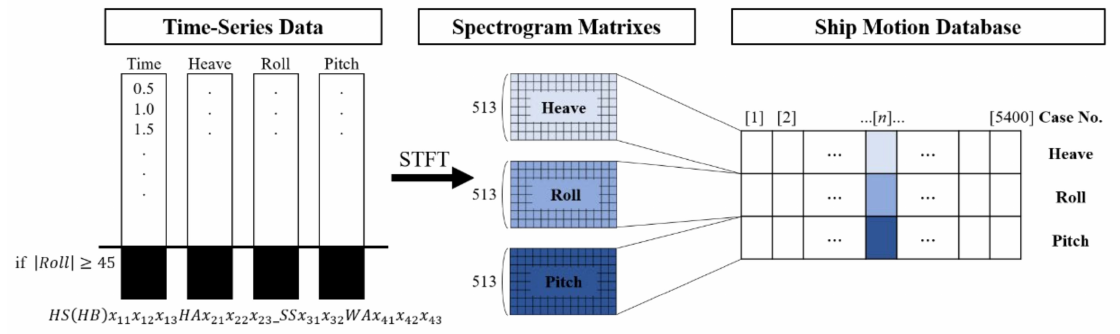
Figure 11. Procedure for ship motion database